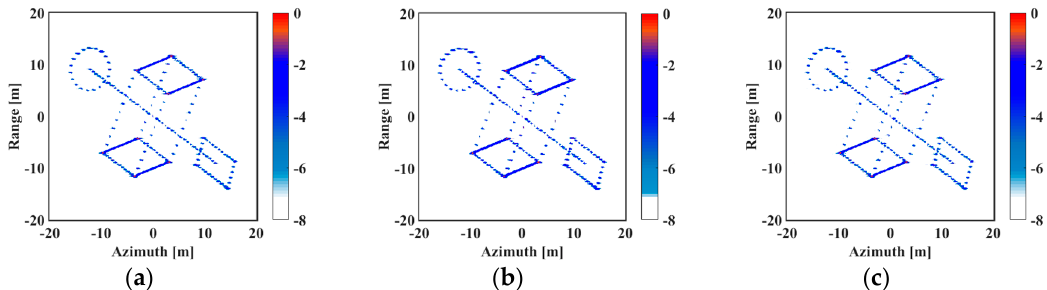
Figure 11. Imaging results obtained by the proposed algorithm under different SNRs: ( a ) SNR = 10 dB; ( b ) SNR = 5 dB; ( c ) SNR = 0 dB.